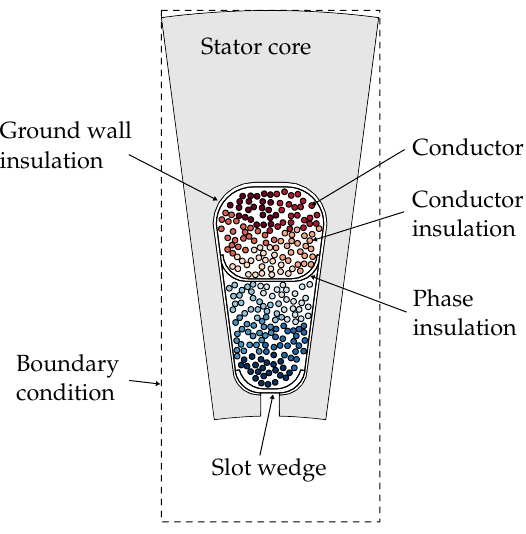
Figure 3. Two-dimensional electrostatic field simulation Figure 3. Two dimensional electrostatic field simulation model